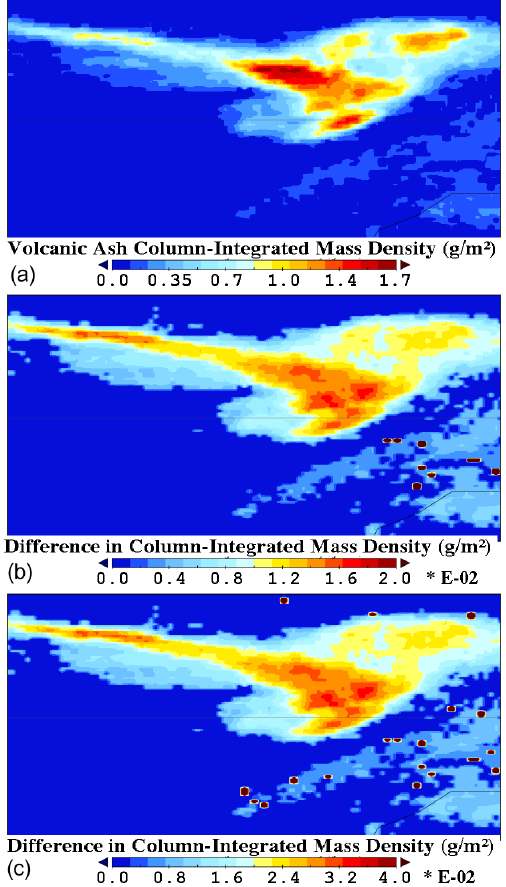
Figure 13. (a) VAMC output over the ocean south-east of Iceland in the triangle enclosed by the Faroe Islands in the south, the Shet- land Islands in the west and the northernmost tip of Great Britain for 17 May 2010 01:00UTC from the operational DWD processing chain. (b) Difference in VAMC between the normal run and the run with surface temperatures increased by + 1K. (c) Same as in (b) , but with a skin temperature increase by + 2K.